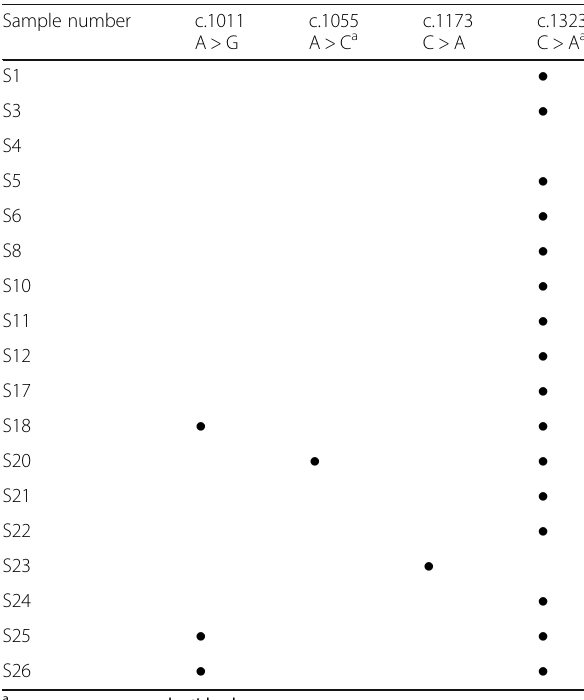
Table 4 Nucleotide changes identified in HPV84-L1 when compared to the reference sequence (AF293960) in eighteen HPV84+